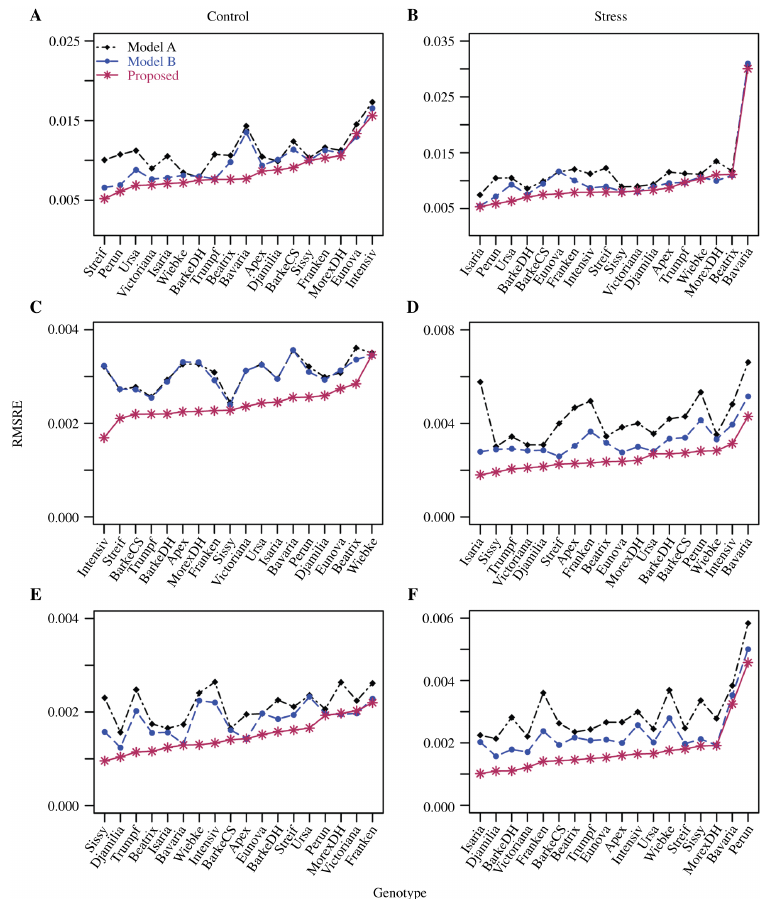
Figure 2: Performance evaluations of the proposed image-derived biomass model. Performance evaluations of the pro- posed model in different barley cultivars using RMSRE, under different water condition of two